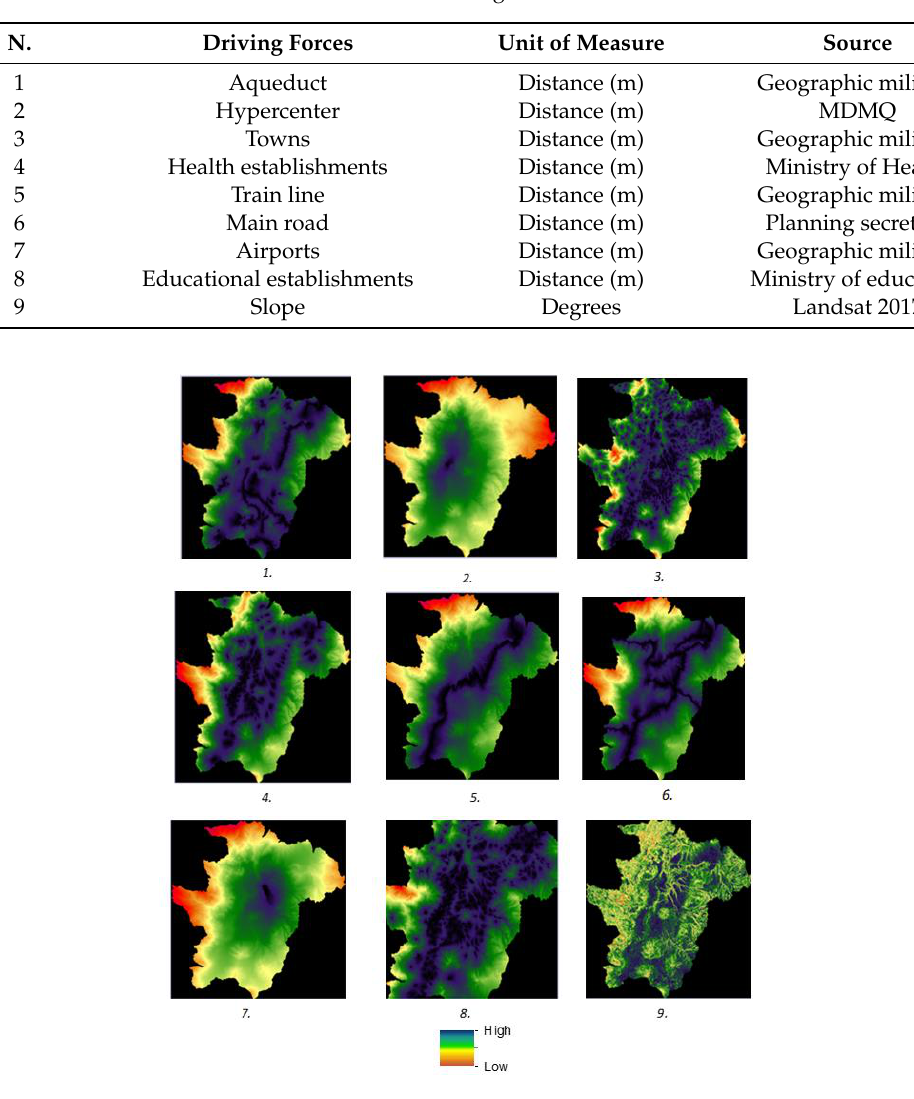
Figure 5. Spatial representation of driving forces.